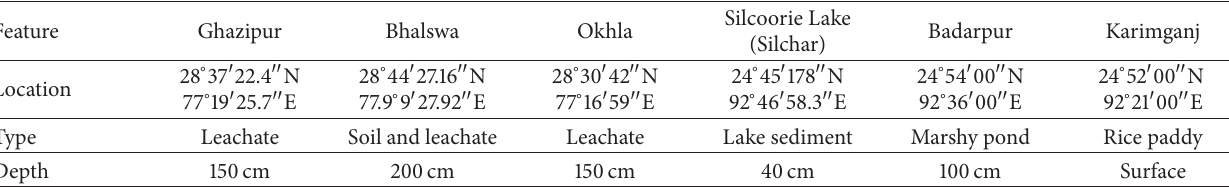
Table 1: Sampling point from Delhi landfill site (Ghazipur, Bhalswa, and Okhla) and Southern Assam marshland (Silcoorie Lake (Silchar), Badarpur, and Karimganj)